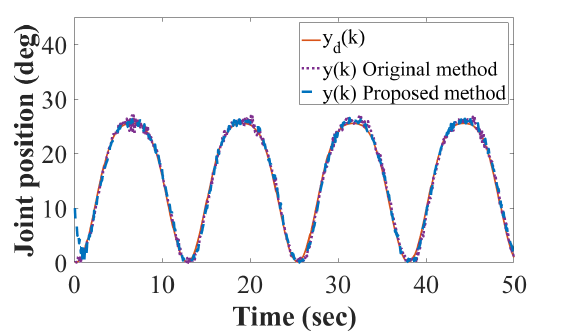
Figure 14. Experimental result (joint position).